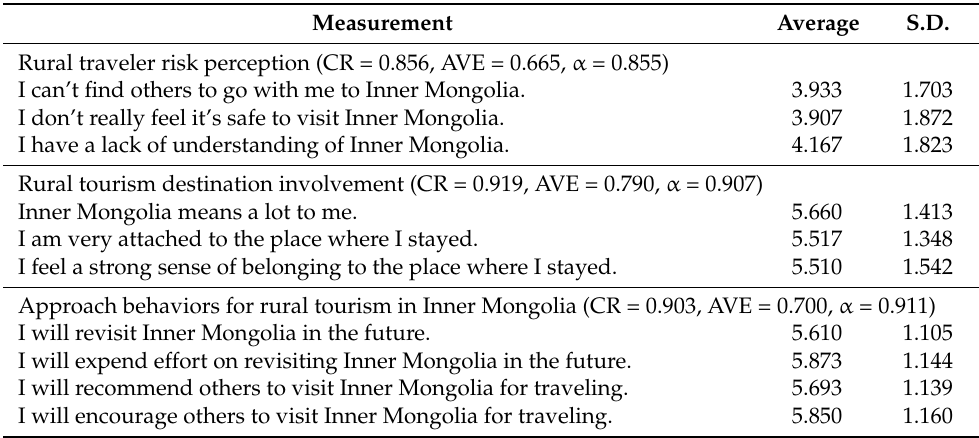
Table 1. Cont. Measurement Average S.D.